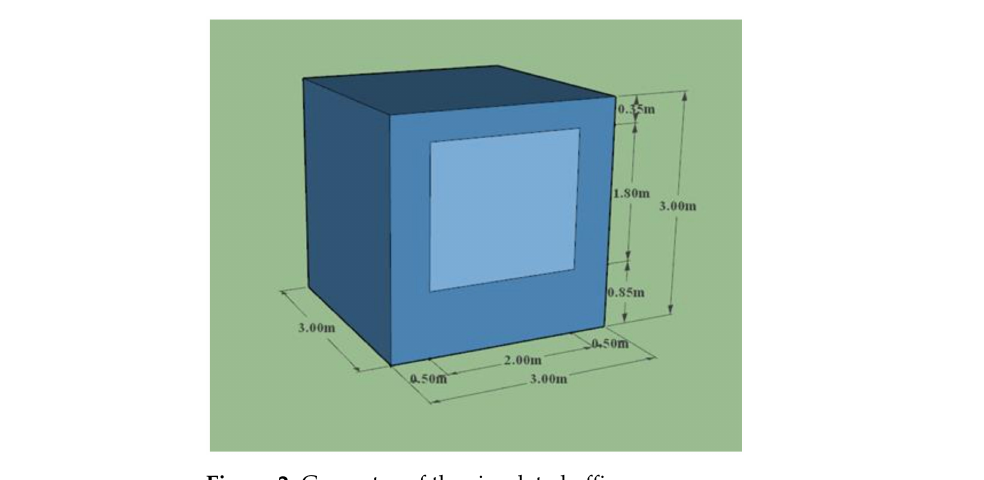
Figure 2. Geometry of the simulated office space. Table 2. Building envelope properties defined for the five climate zones according to GB